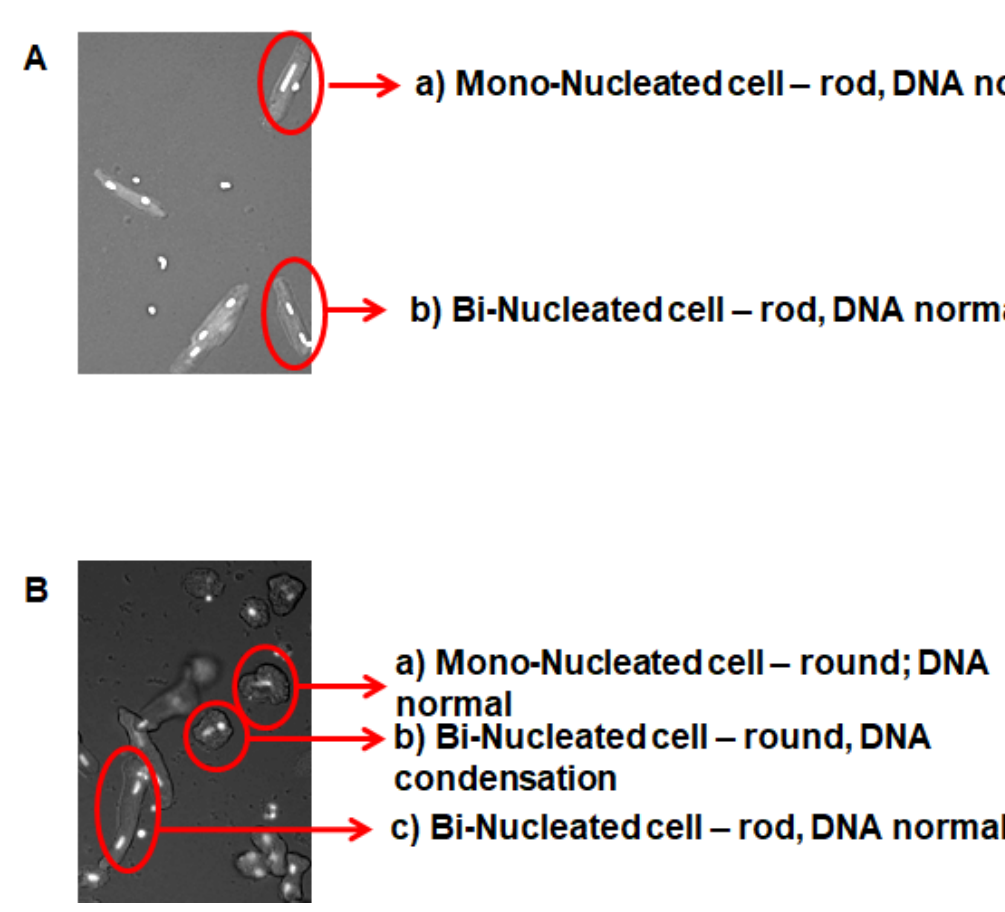
Figure 1. Representative pictures of adult rat ventricular cardiomyocytes. ( A ) Freshly isolated cardiomyocytes are shown; ( B ) cardiomyocytes after 48 h cultivation in the presence of fetal calf serum.